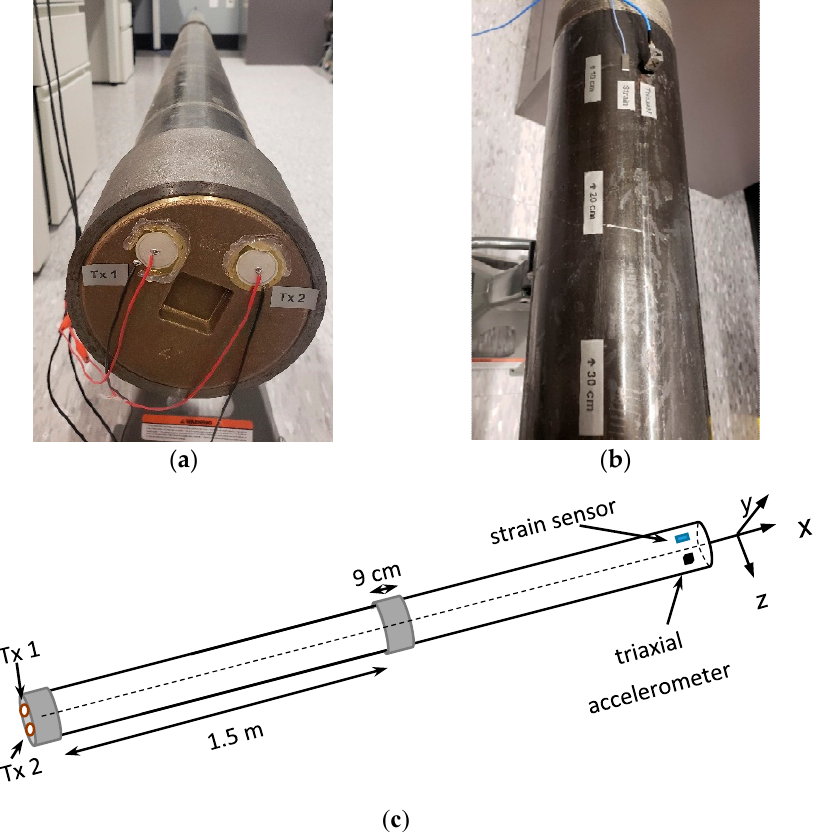
Figure 1. The drill string testbed: ( a ) two piezoelectric transmitters labeled as Tx 1 and Tx 2; ( b ) two receiver sensors, including one strain sensor labeled as Strain, and one triaxial accelerometer labeled as Triaxial; ( c ) schematic drawing of the testbed.